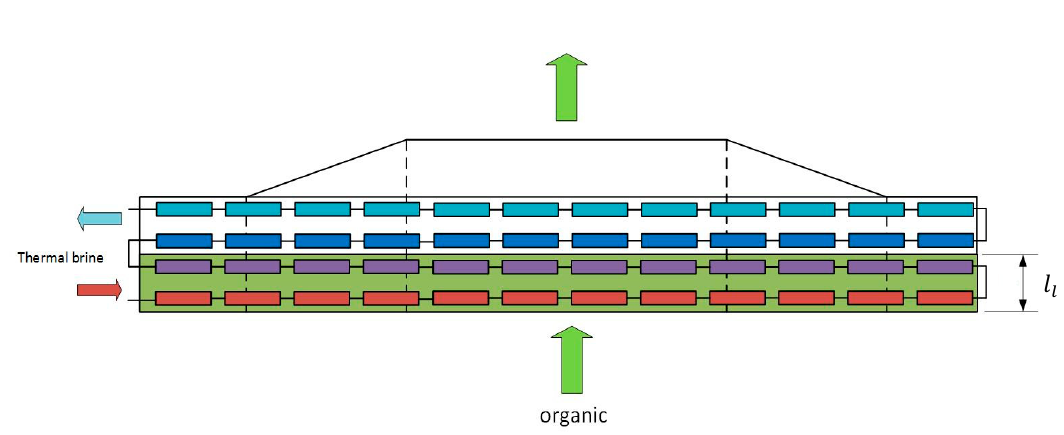
Figure 5. Kettle boiler side view and flow scheme.